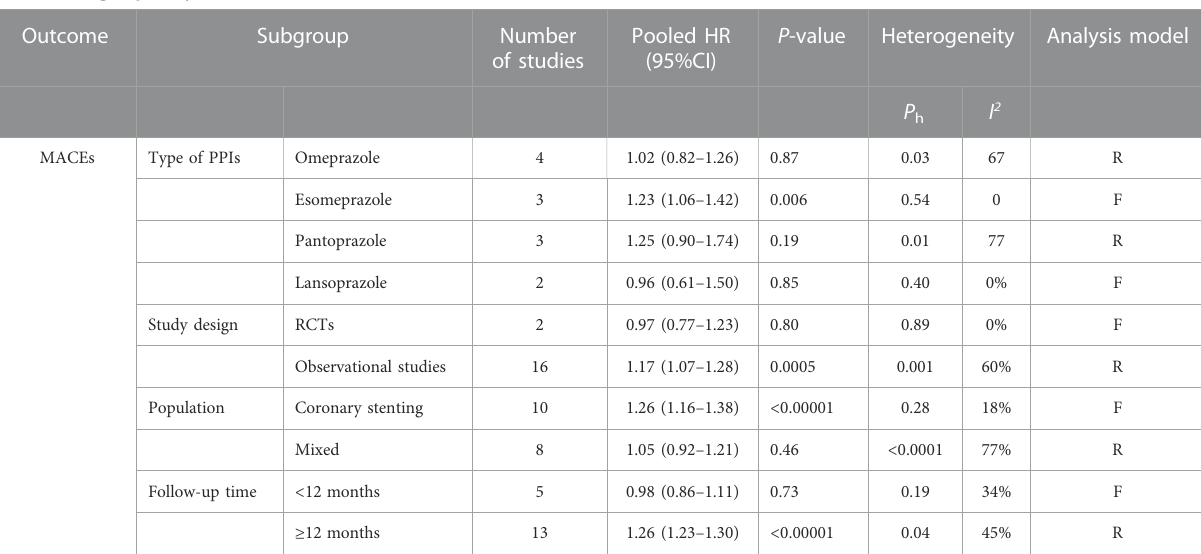
TABLE 2 Subgroup analysis of